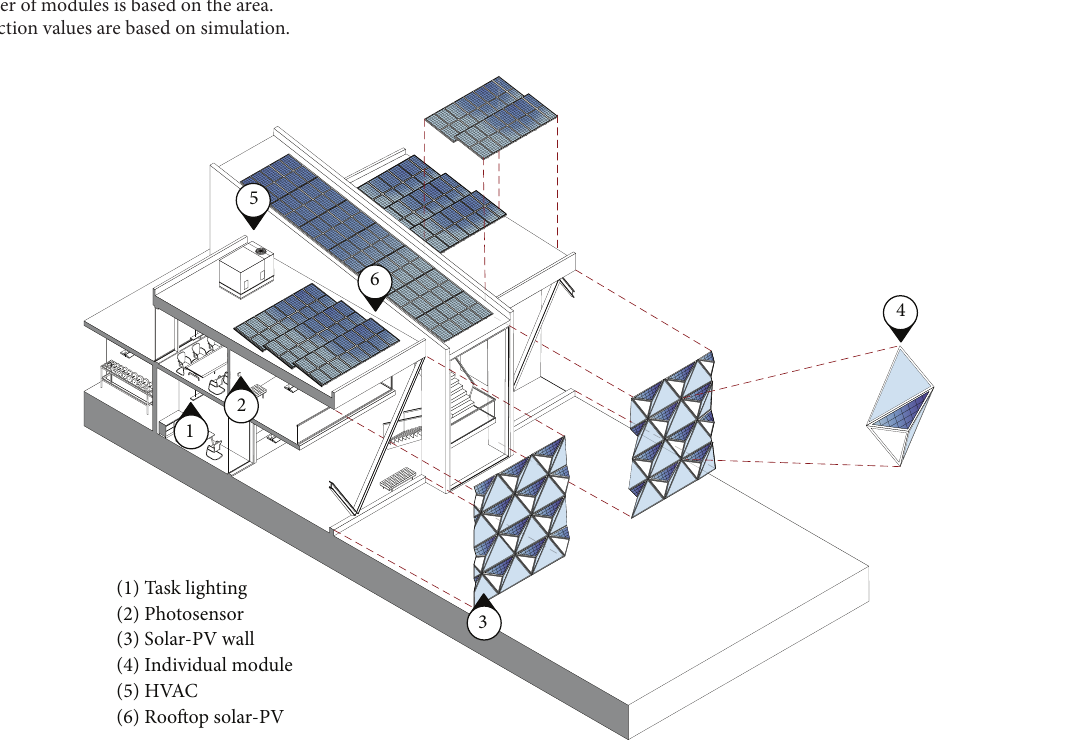
Figure 6: Solar-PV array in the